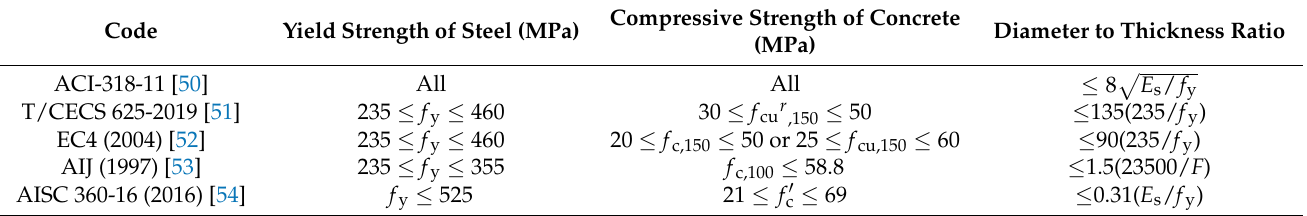
Table 4. Range of applicability of design equations for circular CFST/RACST